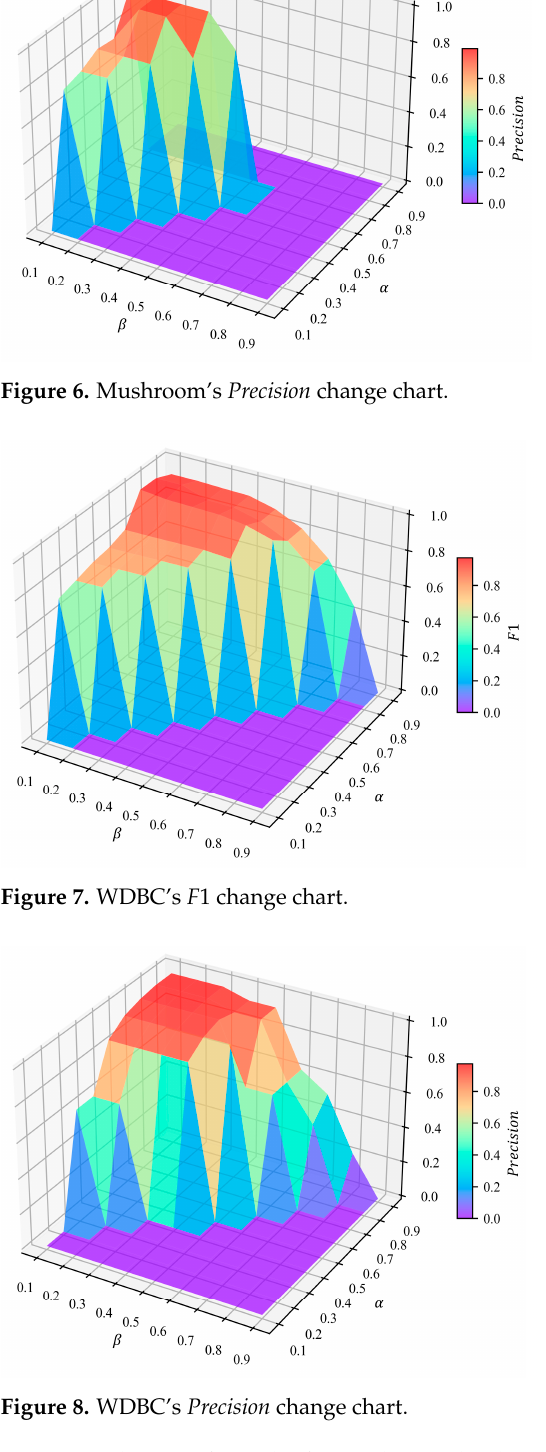
Figure 8. WDBC’s 𝑃𝑟𝑒𝑐𝑖𝑠𝑖𝑜𝑛 change chart.